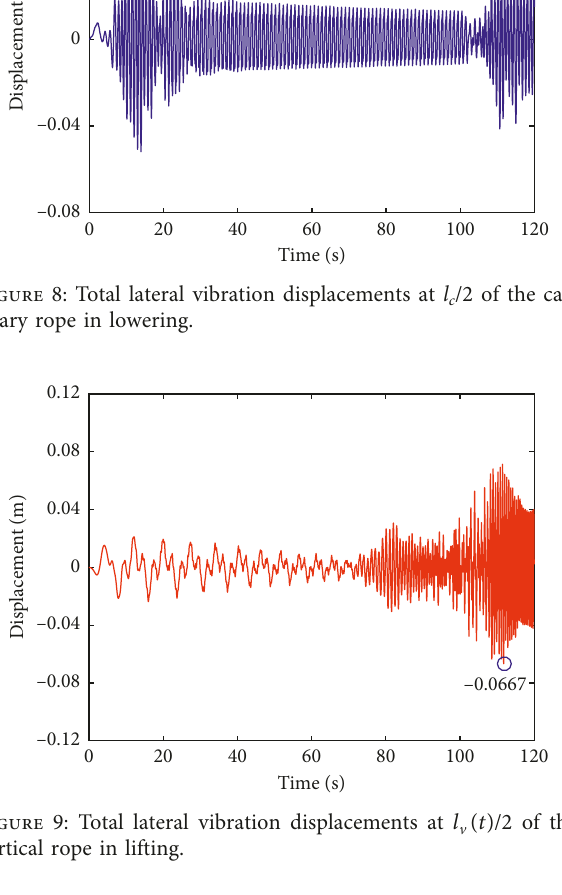
Figure 9: Total lateral vibration displacements at l vertical rope in lifting.